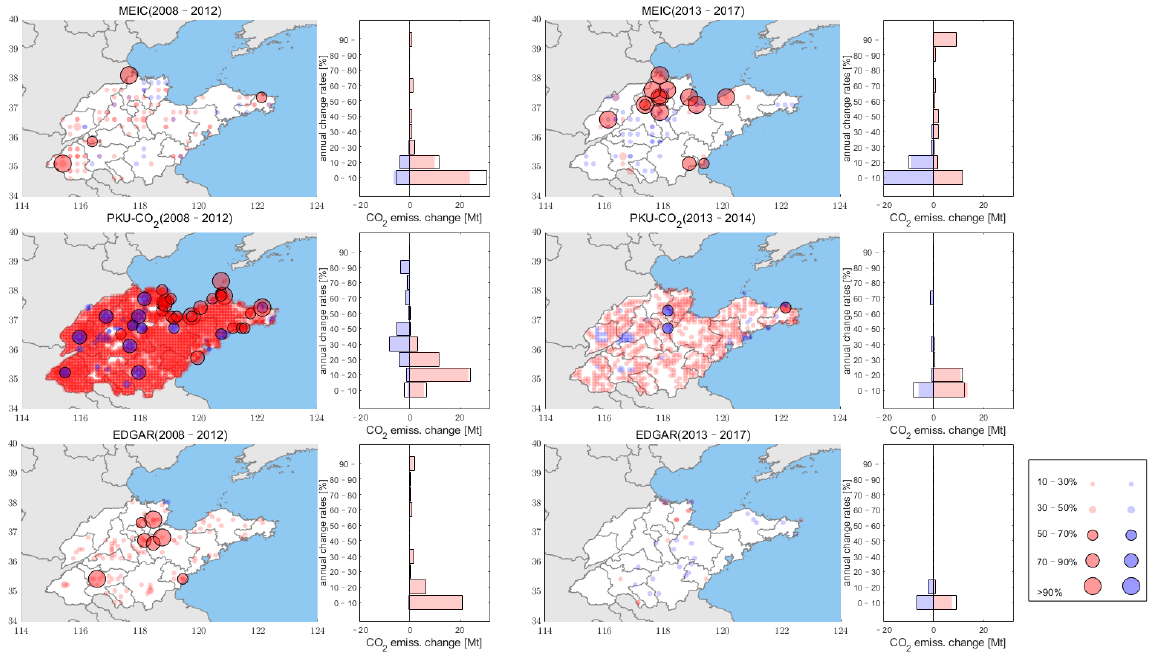
Figure 7. The change rates of grid emissions for three inventories during their covered period before 2012 ( left column ) and after 2012 ( right column ). The change rates for each grid are derived by 100% × (𝑒 𝑖𝑦𝑒𝑎𝑟+1 − 𝑒 𝑖𝑦𝑒𝑎𝑟 )/𝑒 𝑖𝑦𝑒𝑎𝑟 . The red circles indicate increasing rates (>10%), while blue circles indicate decreasing rates (< − 10%). The sizes of the circles are proportional to the change magnitudes, and the circled marking change rates over 50% are plotted with black edges. The bar-plots on the left side of each map show the corresponding cumulative annual change emissions (outlined in black) and the amount of industrial emissions (shaded in color), which are sorted using the different gridded change scales (y-axis).